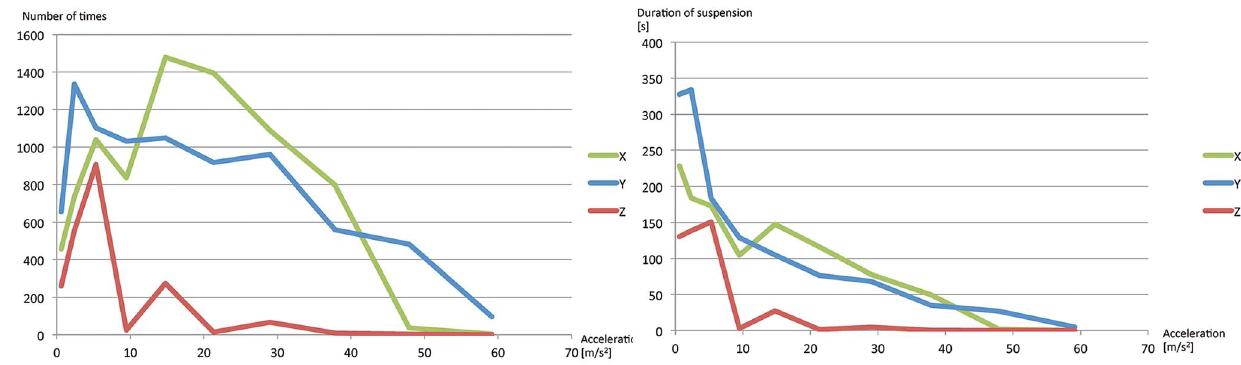
Figure 6. Results of stability experiments on different directions of movement. The horizontal axis shows the maximum acceleration (cm/ s 2 ) within back-and-forth motion. The green, blue, red lines show the results of along x-, y-, and z-axes. (Left) The vertical axis shows the average number of times (the duration divided by the periodic time). (Right) The vertical axis shows the average duration of suspension [s]. Both show the same experimental results. Figure 5 is for different sizes of a particle (0.6 mm, 1.0 mm, and 2.0 mm) and Figure 6 is for different directions of the movement (x, y, and z axes) of a 0.6-mm-diameter particle.